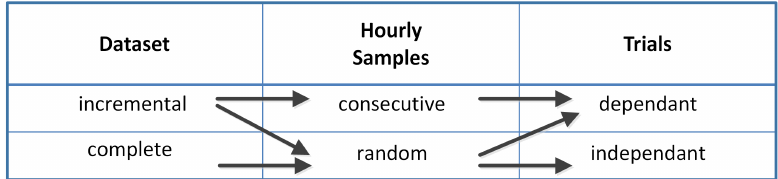
Figure 1. Main features of the ANN training